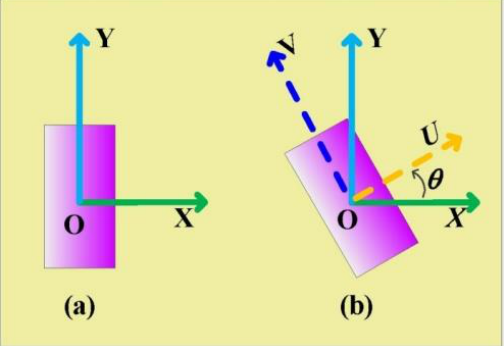
Figure 1. Illustration of PB phase unit-cell: ( a ) PB phase unit-cell in the xy coordinate; ( b ) PB phase unit-cell in the uv coordinate, which is transformed by an θ anticlockwise rotation of the original xy coordinate. Both coordinates have the same original point.